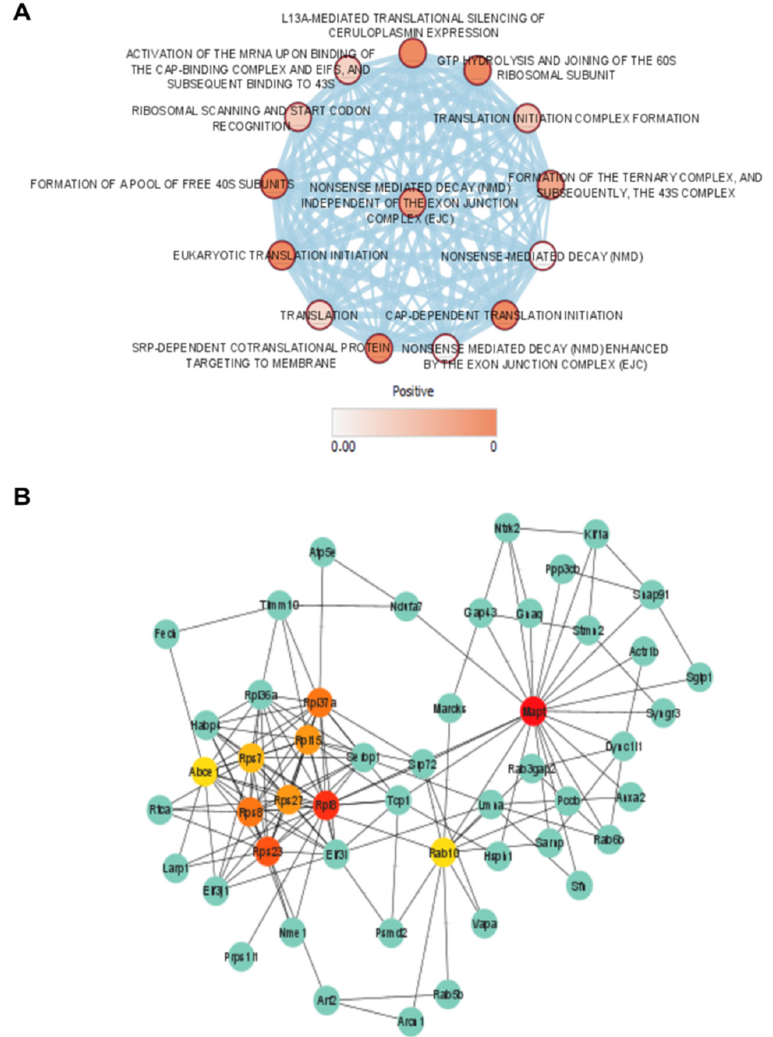
Figure 3. Network and pathway enrichment analysis of the DEP list of 16-week L-NAME-untreated and -treated hippocampal tissue of C57BL/6 mice. ( A ) Pathway enrichment analysis output from g:Profiler including the KEGG, REACTOME, and WikiPathways databases visualized via the Cytoscape Enrichment Map. Each circle depicts individual gene sets ranked from low (white) to high (red) Q-value positivity. Interactions between different gene sets are indicated by blue lines. ( B ) Protein network (Cytoscape) from the String output (version 11.5, available on: https://string- db.org (accessed on 25 January 2022)) of the complete DEP list. The protein network only depicts proteins displaying a node interaction with top 10 essential nodes (cytoHUBBA in Cytoscape) ranked by node degree from highly essential (red) to normal (green).